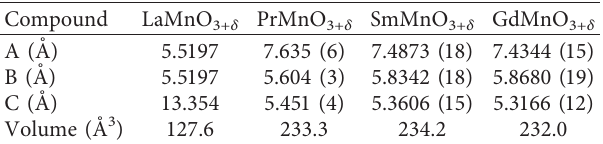
Figure 1: A sketch of a setup for measurements on cone-shaped electrodes. The setup is used for evaluating the ability of electrode materials to electrochemically reduce either oxygen (not shown) or nitric oxide. The setup is a pseudo-three-electrode setup as the size of the counter/reference is many times larger than that of the working electrode (the cone). It is seen that the nitric oxide is reduced to nitrogen and oxide anions, at the cone-shaped electrode. The setup is a two-atmosphere setup. Table 1: The unit cell parameters for the four perovskites. It is seen that the unit cell becomes more and more distorted from the ideal cubic perovskite structure, when the size of the A-site cation is